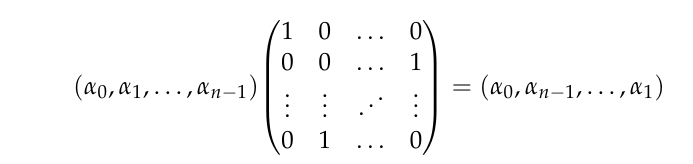
Figure 6. A c ircuit forthe 2 QFT . For a 2 2 n